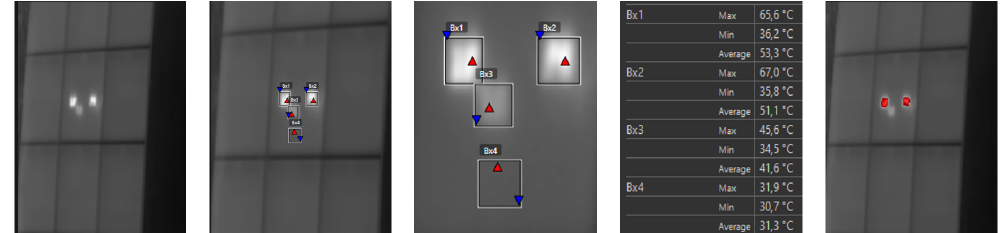
Figure 6. Considering only severe failures, two hotspot defects are detected.